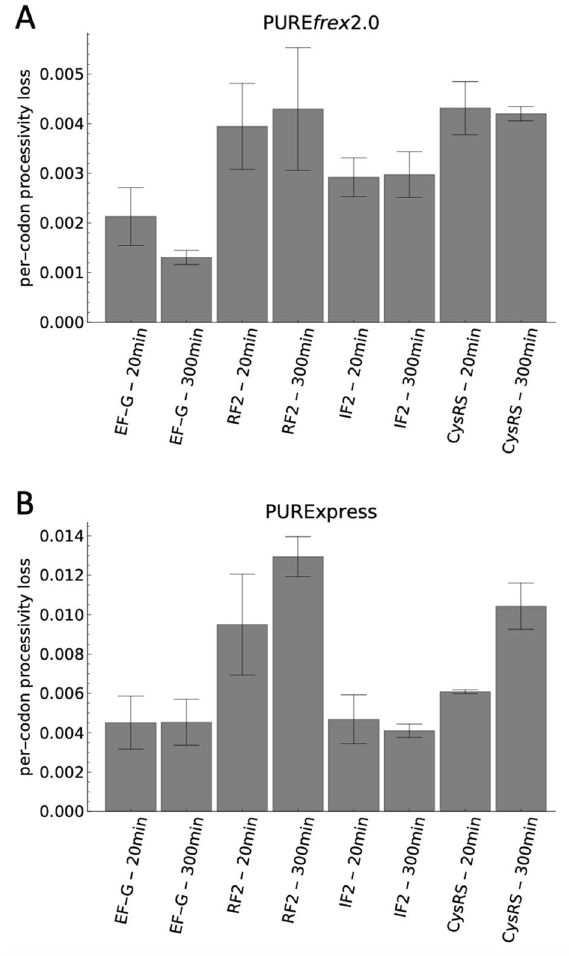
Figure 4. Quantification of processivity loss with pTFM1 as a template. Average per-codon processivity loss of the indicated proteins expressed in PURE frex 2.0 ( A ) or in PURExpress ( B ) for 20 min or 300 min. Bar heights are slope values obtained from weighted fitting of data shown in Supplementary Fig. 4 and error bars are weighted fit